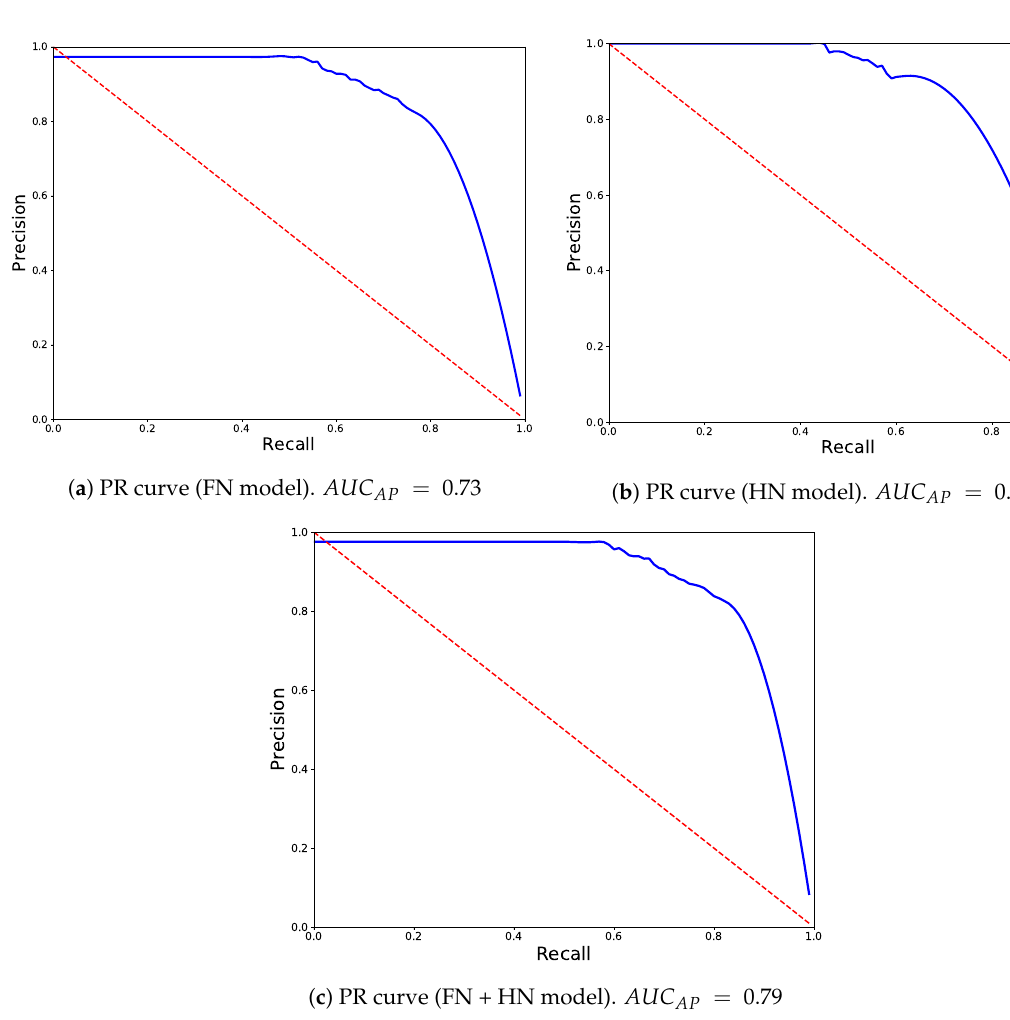
Figure 13. Precision-Recall curves for the FN, HN and FN + HN